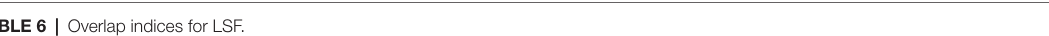
TABLE 6 | Overlap indices for LSF.